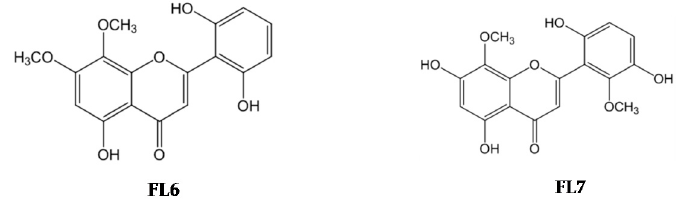
Figure 2. Structures of flavones isolated from Scutellariae radix .